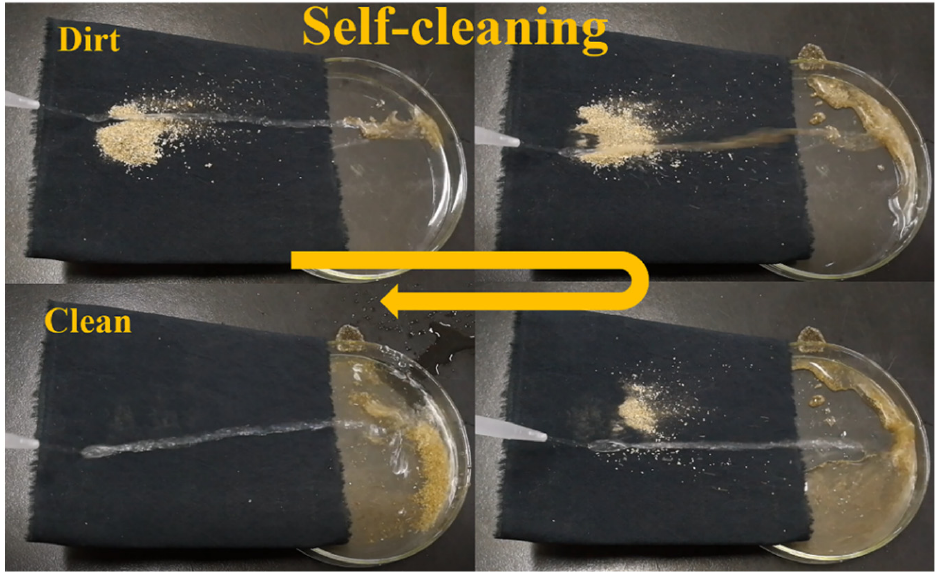
Figure 5. The self-cleaning property of the PDMS/STA/SiO 2 -coated fabric.